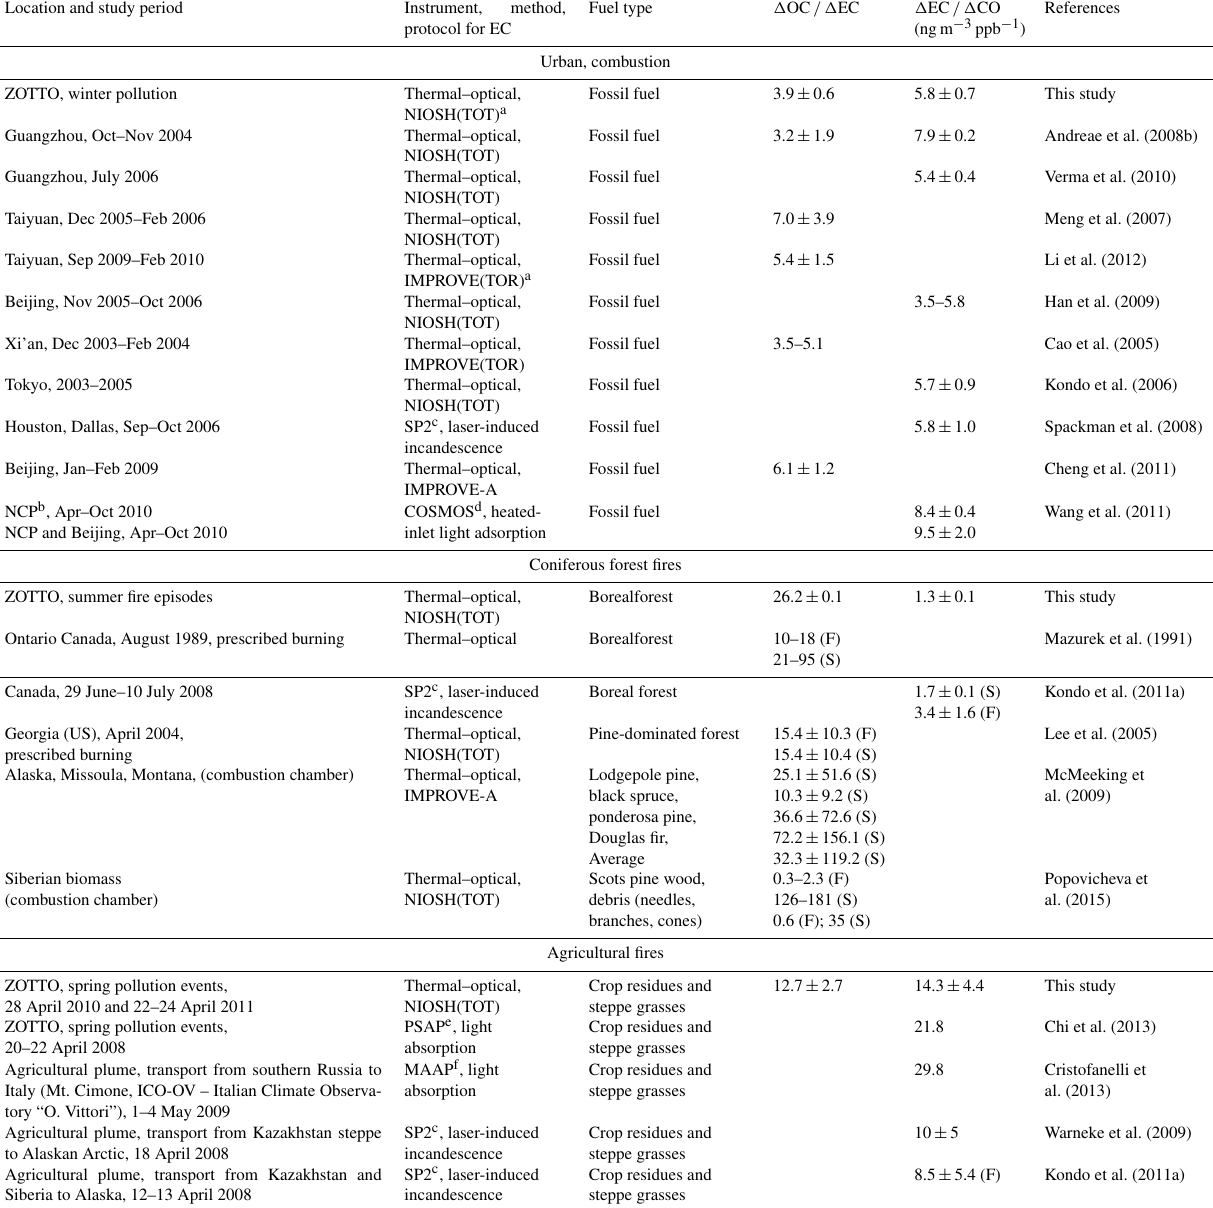
Table 3. Comparison of (cid:49) OC /(cid:49) EC and (cid:49) OC /(cid:49) EC at ZOTTO with values obtained from previous data sources. F, S, and M stand for flaming, smoldering, and mixed burning mode,